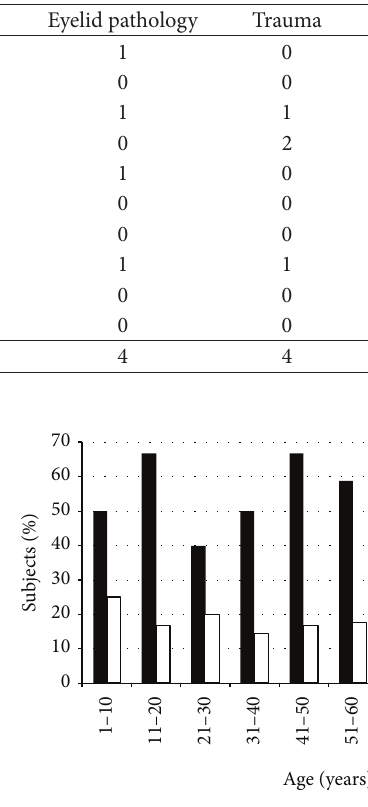
Figure 2: Percentage of subjects suffering and not suffering from OSD by age group. Black bars: presence of OSD; white bars: absence of OSD.